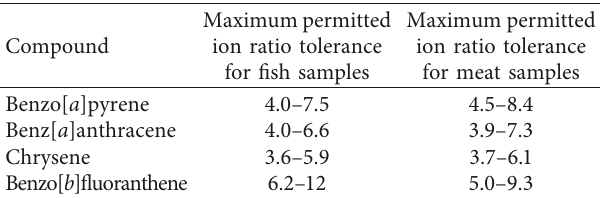
Table 2: The calculated maximum permitted ion ratio tolerance for fish and meat